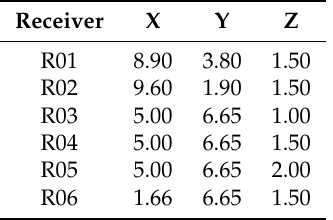
Table 1. Receiver locations included in this study (locations specified in m in terms of the coordinates shown in Figure